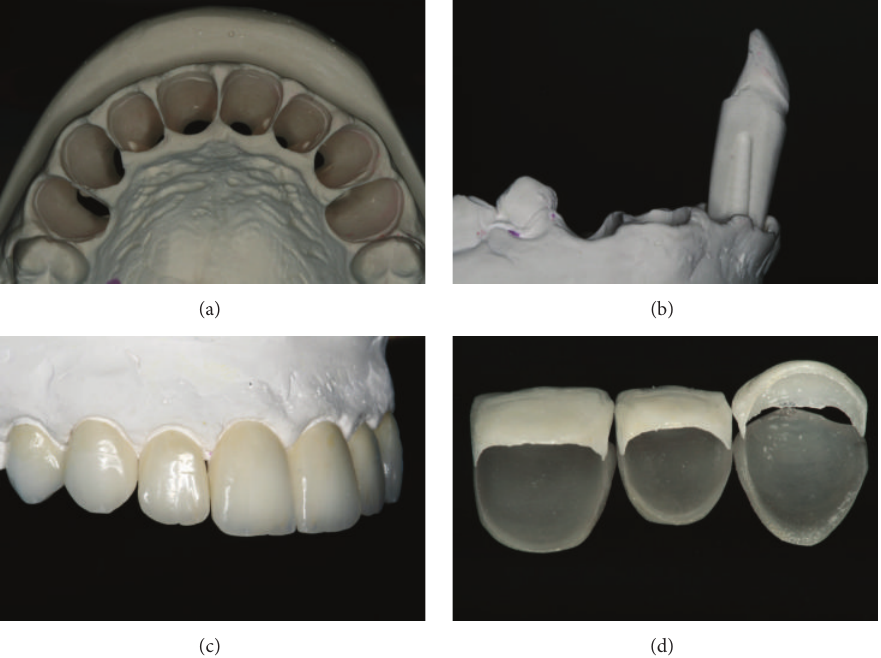
Figure 7: (a)–(d) Model with die in position for creation and ceramic finish to allow for an extremely precise and conservative restoration.